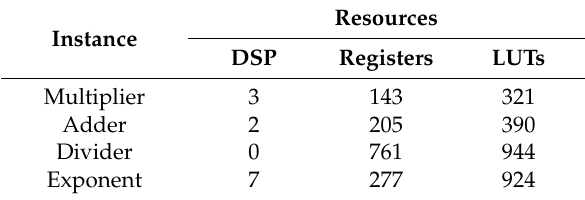
Table 5. Resource utilization of single precision operations on Xilinx Zynq FPGA.